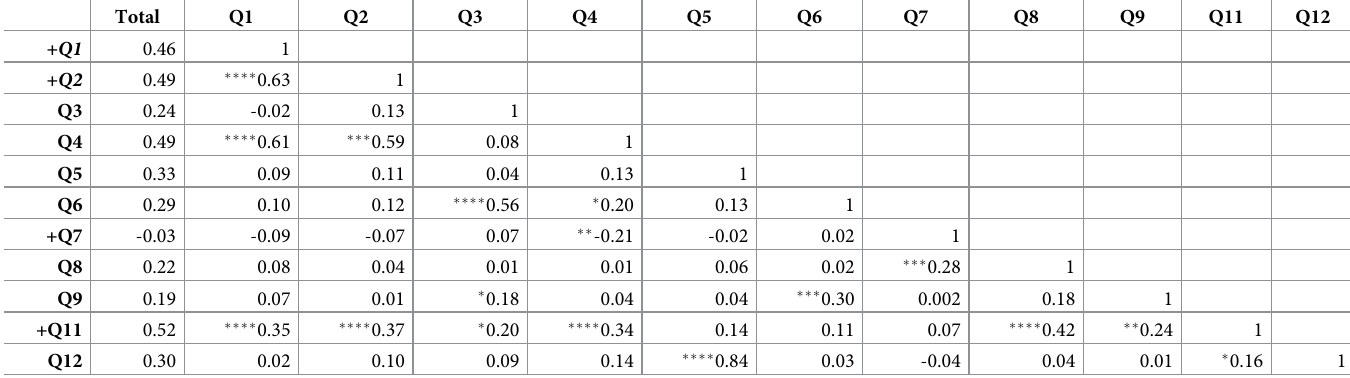
Table 4. HEWS item to total and item to item